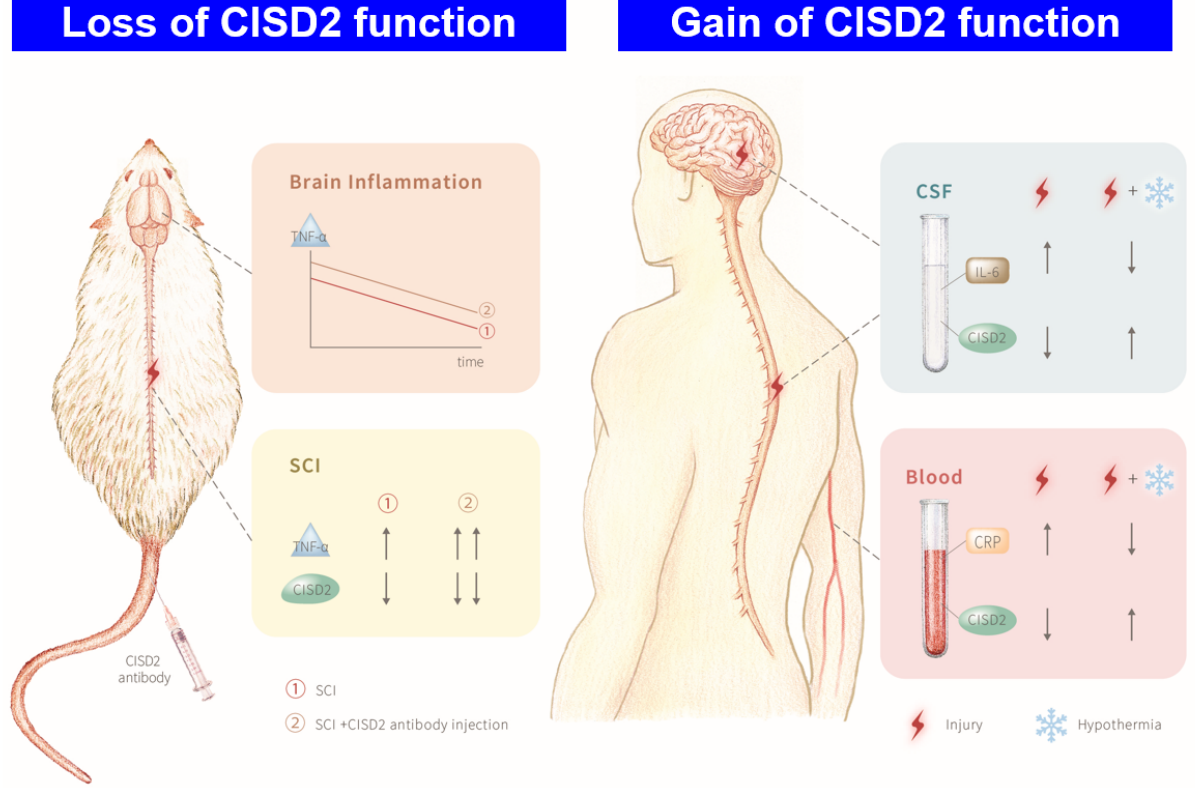
Scheme 1. Illustration of Cisd2 depletion in the mouse model of spinal cord hemisection injury and CISD2 potentiation in patients with central nervous system (CNS) insults. As indicated in the left panel, spinal cord injury (SCI) decreases the expression of Cisd2 and promotes inflammation in the spinal cord and brain. Inhibition of Cisd2 using the anti-CISD2 neutralizing antibody exacerbated SCI-induced inflammation in the brain and spinal cord. Right panel shows a schematic representation of a patient with CNS insults exhibiting decreased plasma and cerebrospinal fluid (CSF) levels of CISD2 and elevated levels of inflammatory mediators. Therapeutic hypothermia potentiates CISD2 function and decreases the plasma levels of CRP and the CSF levels of IL6. The results of CISD2 inhibition and potentiation studies revealed the anti-inflammatory properties of CISD2.